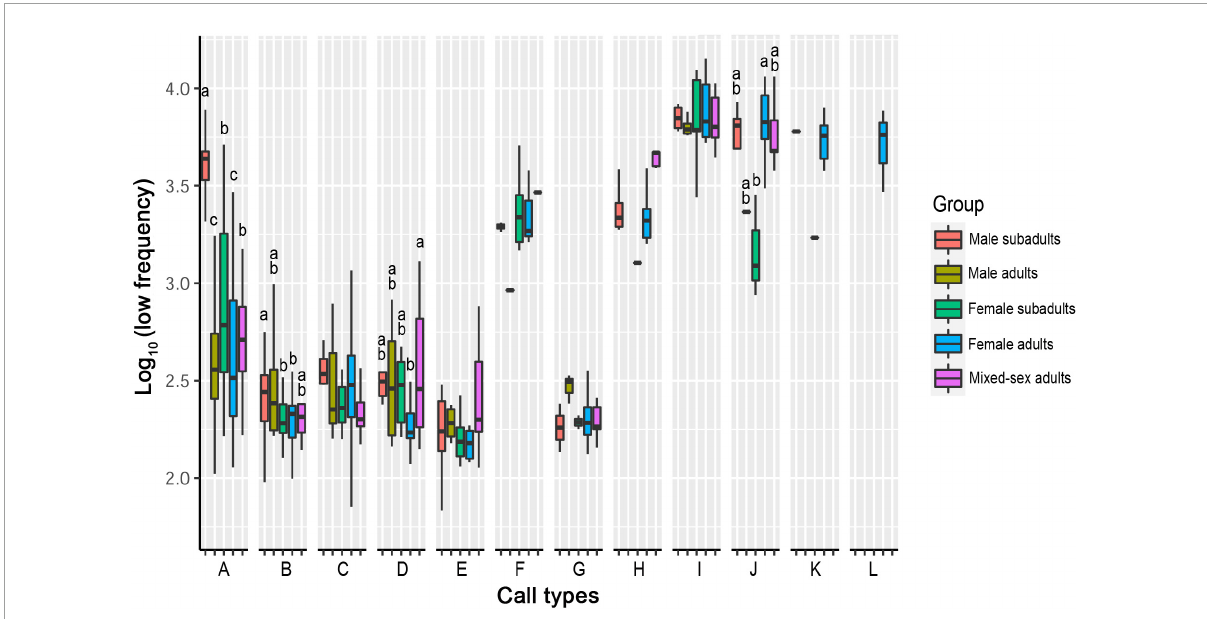
FIGURE4 Differences in low frequencies among five sex–age groups for all call types. The y -axis is the log-transformed value of low frequency. The x -axis represents the call types. Boxplots with different lowercase letters refer to Kruskal–Wallis comparison tests yielding significant results ( P < 0.05), and the relationship among the letters is a > b > c > d. Boxplots with the same lowercase letters did not significantly differ ( P > 0.05). Call types without letters on the boxplots showed no significant differences among sex–age groups.